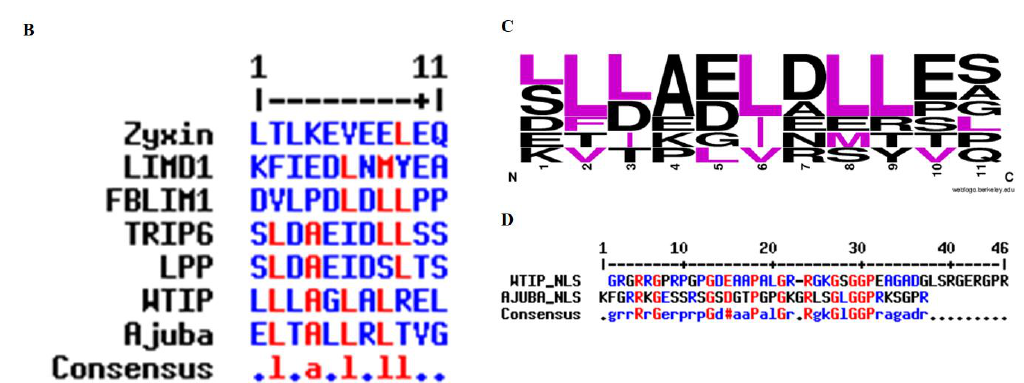
Figure 2. ( A ) The nuclear export sequences (NES) of Zyxin family proteins. To investigate the conservation of NES in proteins from other organisms, we aligned the human protein sequence using BLAST against the non-redundant protein sequence database. The resultant sequences obtained from BLAST were subjected to multiple sequence alignment, presented using WEBLOGO ( B ) The NES sequence for each protein was identified through the NetNES webserver, and the sequences were aligned using MultAlin. ( C ) WEBLOGO was used to investigate the conservation of residues in the sequences, which suggested the presence of signature LxxLxL/LxxxLxL, (L = L/V/I/F/M; x = any amino acid) repeat, in NES sequence across all the members of Zyxin family except zyxin and LPP which showed LxxxLxxL/LxxLxxL consensus sequence. ( D ) The nuclear localization sequence (NLS) for the Zyxin family members was fetched by the NLStradamus webserver with a prediction cut-off set at a recommended value of 0.6. The conservation of predicted sequences was analysed using MulitAlin.